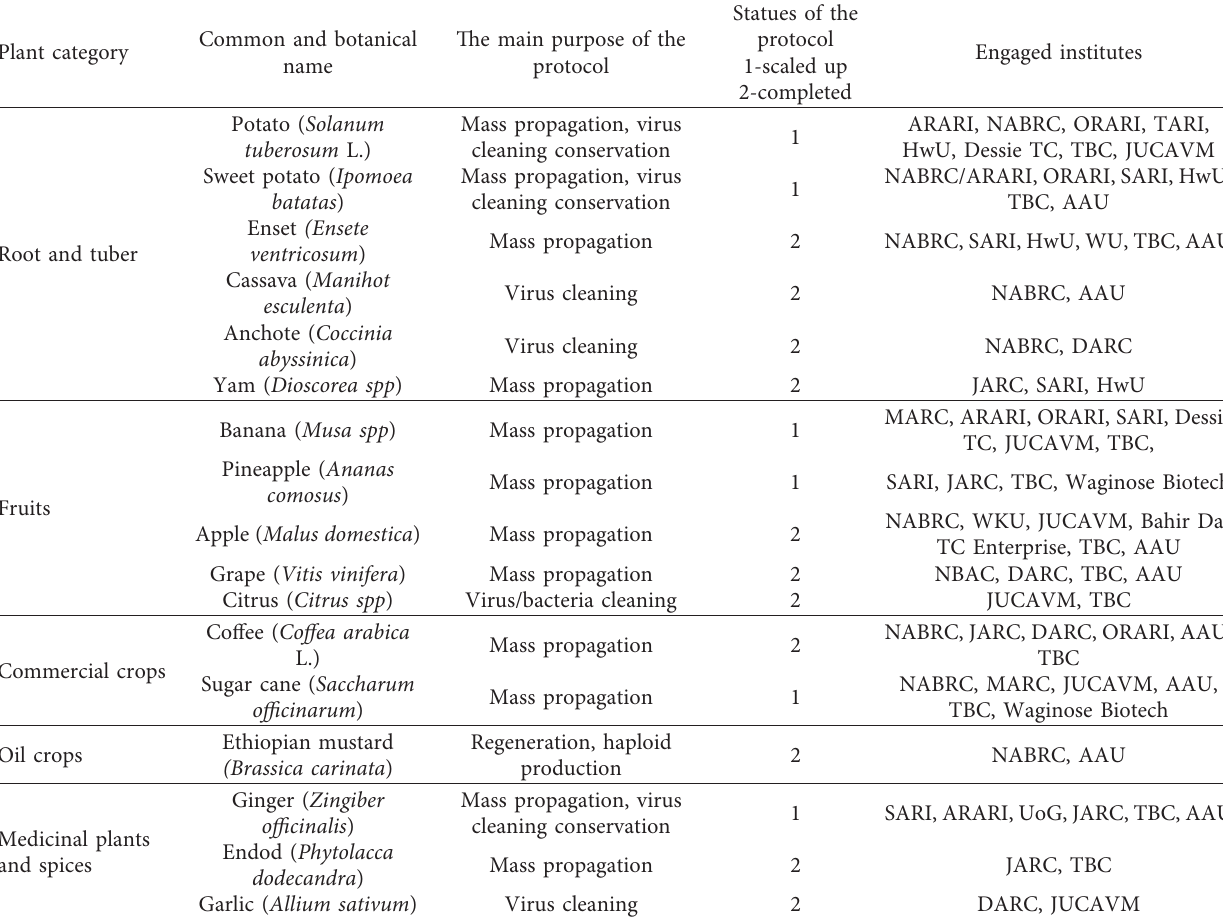
Engaged institutes